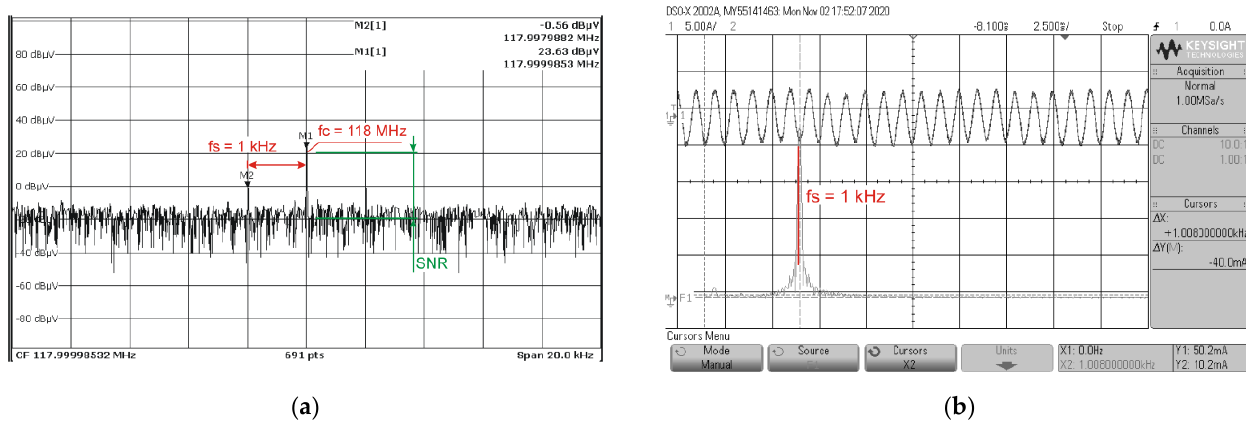
Figure 6. Test signal in the VHF bandwidth for aeronautical mobile services, ( a ) signal in the RF spectrum and the low-frequency (LF) output signal ( b ), in time domain and its spectrum.